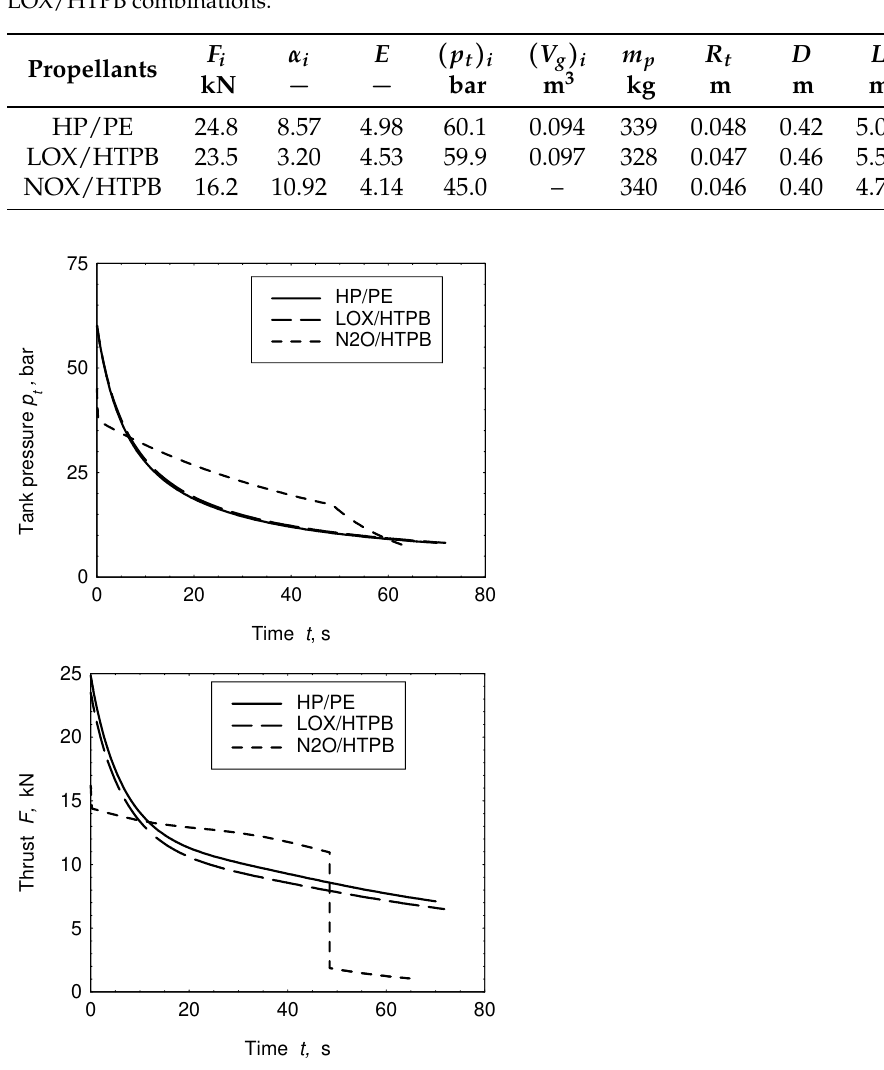
Table 6. Optimal design and performance for the considered propellant combinations. m p , R t , D and L are the propellants mass boarded, the nozzle throat radius, the engine overall diam- eter and length, respectively. ( V g ) i and ( p t ) i are optimization variables only for HP/PE and LOX/HTPB combinations.